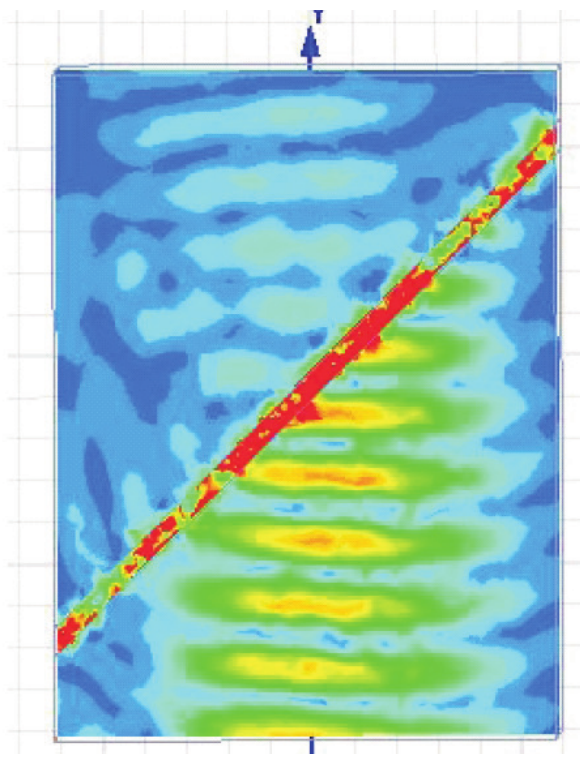
Figure 8. Amplification of the Gaussian beam, shown in the x (cid:48) , z (cid:48)